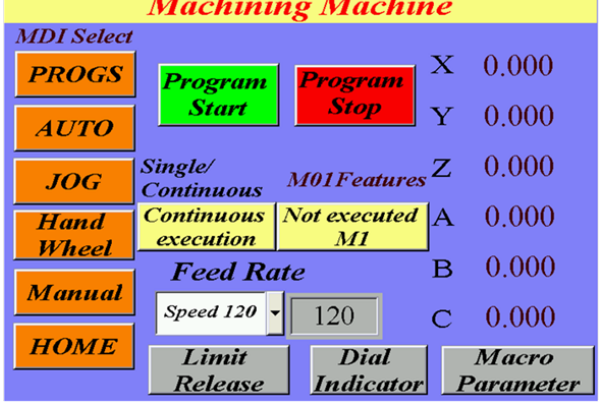
Figure 3. Operation of the DOP-B07E515 human – machine interface.